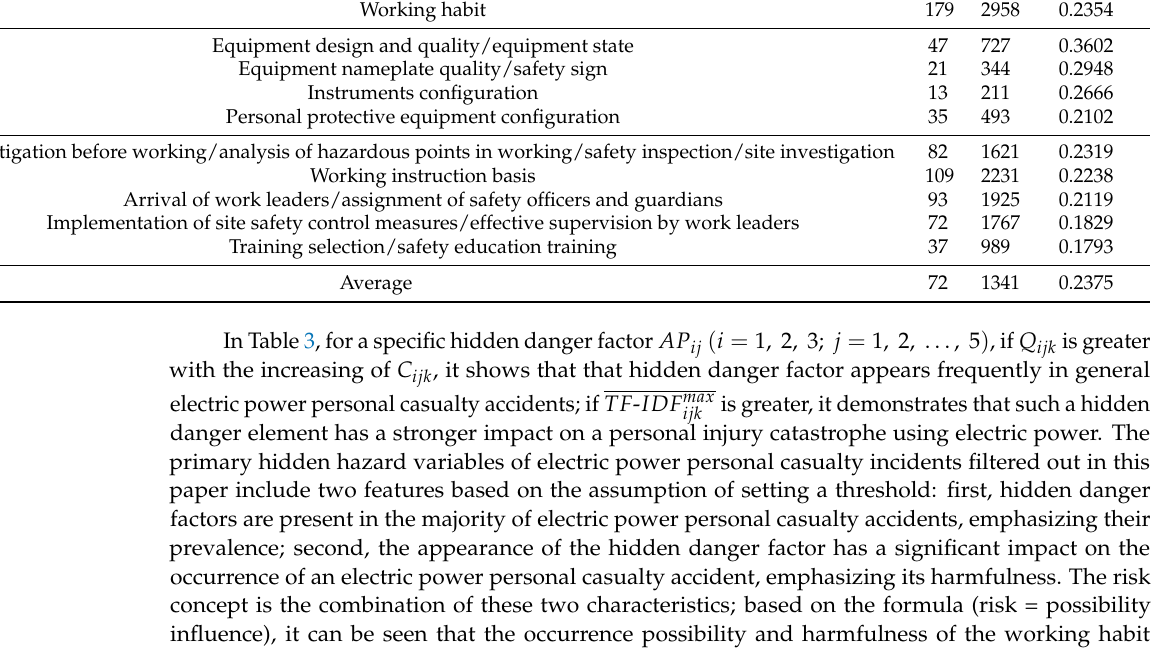
Table 3. Screening Results of Key Hidden Danger Factors of Electric Power Personal Casualty Accidents Based on Term Frequency Count.